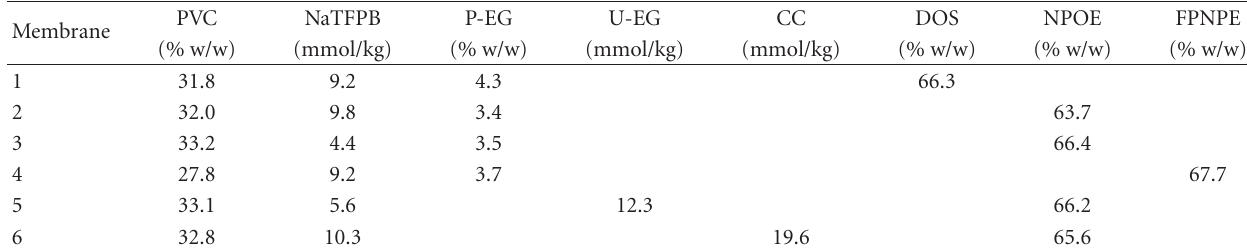
Table 1: Compositions of the Cs + -selective membranes studied in this